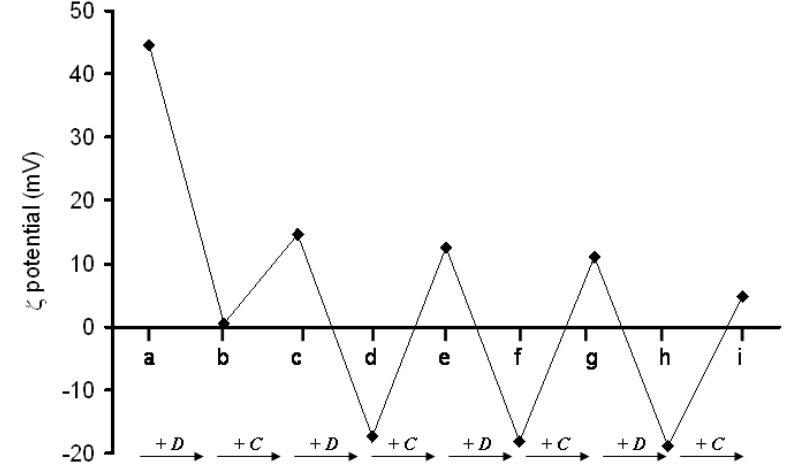
Figure 27. ζ -potential values during the LbL formation; +D: DNA addition; +C: chitosan addition